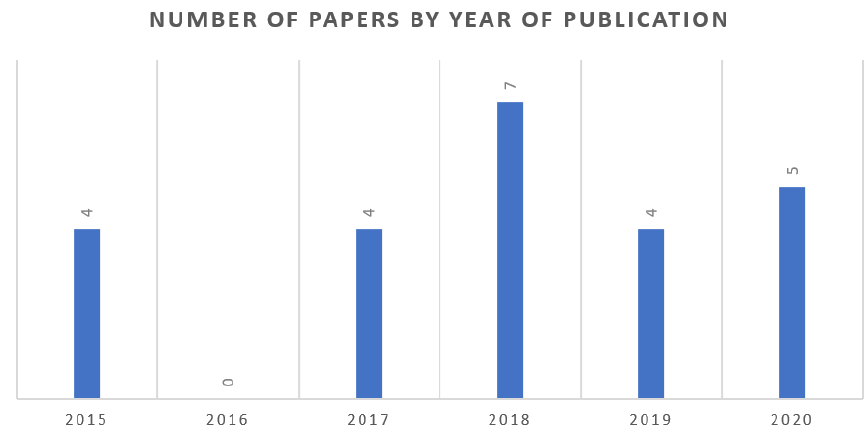
Figure 2. Number of published documents per year of publication (until 30 October 2020).